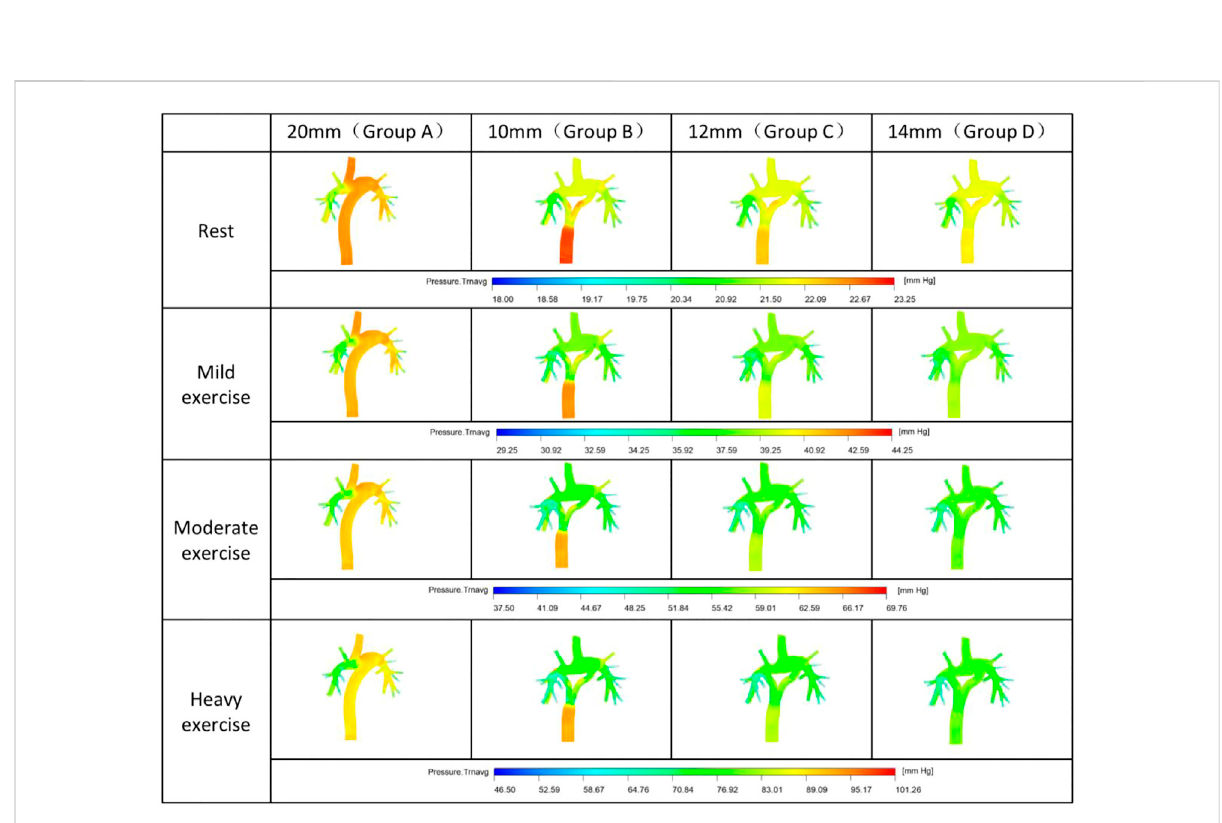
FIGURE 2 Nephogram of pressure